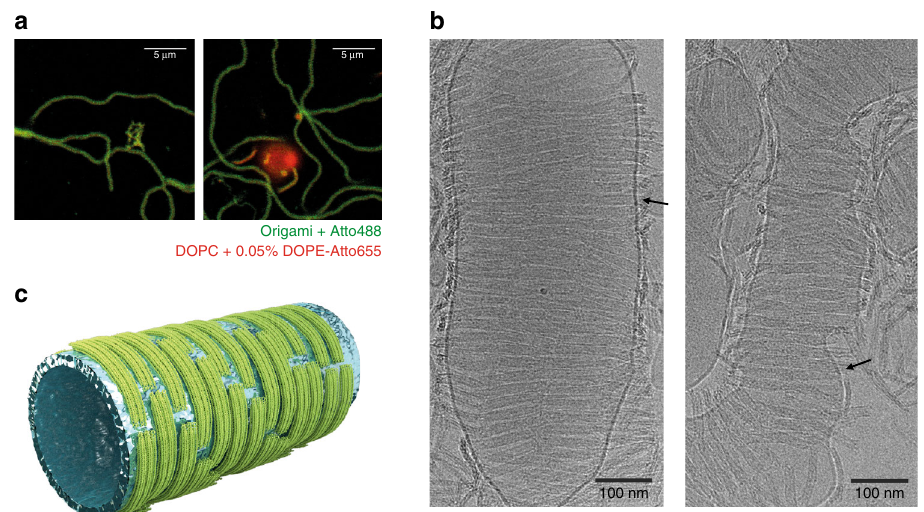
Fig. 5 Ultrastructure of lipid nanotubes decorated with DNA origami Q. a From confocal images, the membrane tubules obtained from GUVs (labeled with DOPE-Atto655; red) upon overnight incubation with structure Q3 (labeled with Atto488) appeared homogeneously covered with membrane-bound DNA origami. b Further cryo-EM imaging con fi rmed that the surface of the membrane tubules (black arrows) is densely covered with curved DNA nanostructures perpendicularly aligned along the long axis. c Based on the cryo-EM electron microscopy observations and radius of curvature of nanostructure Q3, a schematic representation of a lipid nanotube decorated with DNA origami Q is here depicted. Scale bars: ( a ) 5 µ m; ( b )100